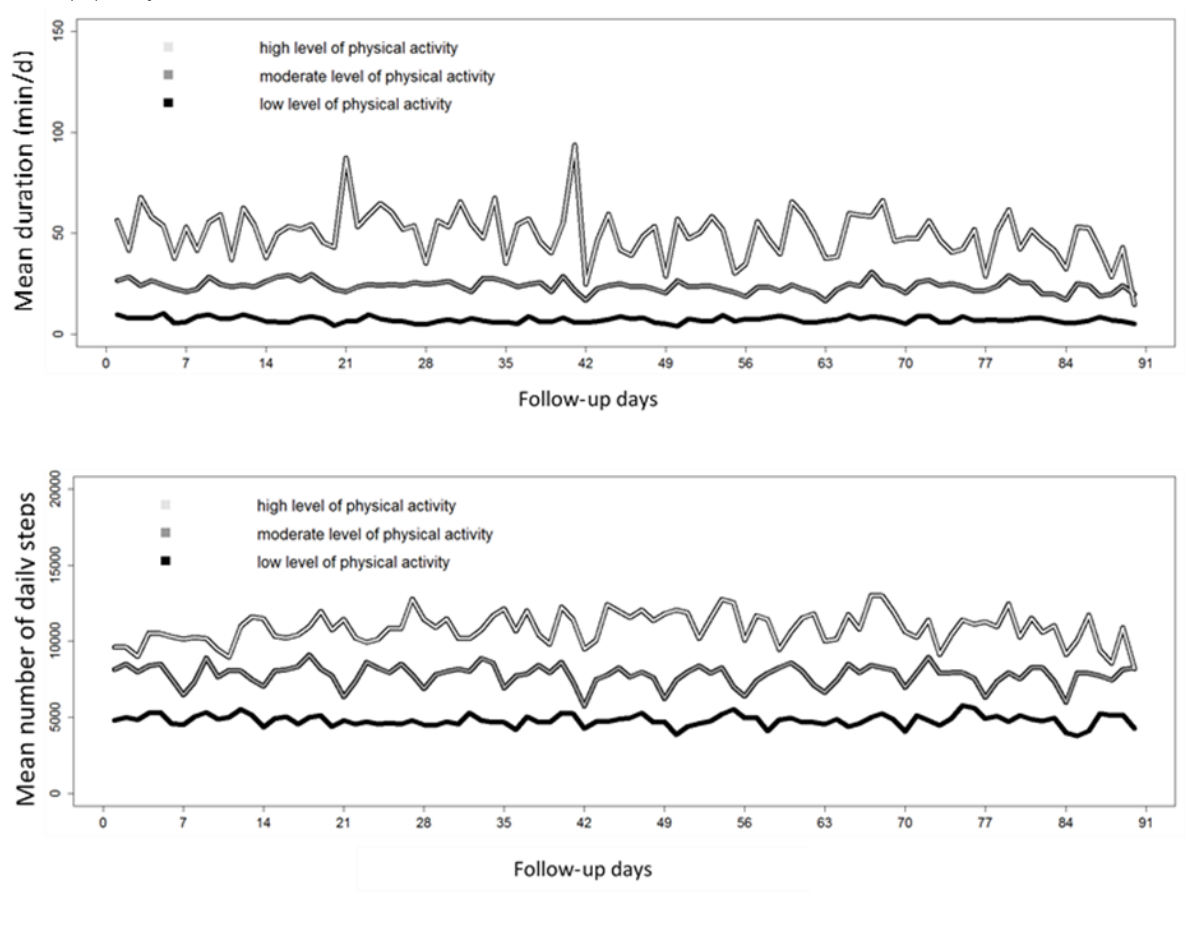
Figure 6. Mean trajectories over 3 months of all patients partitioned in 3 clusters according to: (A) moderate to vigorous activity duration and (B) number of steps per